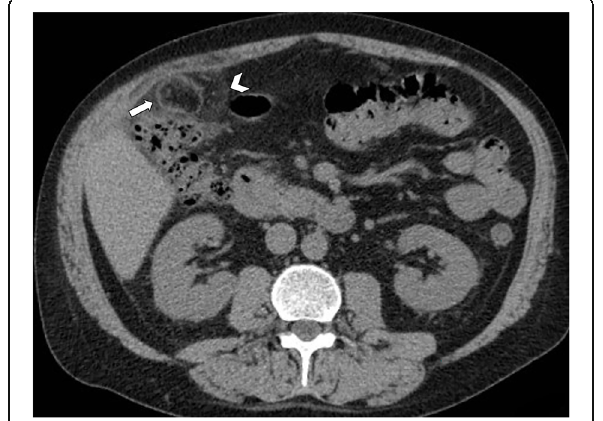
Fig. 4 Acute epiploic appendagitis in a 53-year-old man. Axial non- contrast CT image demonstrates a fat-density lesion (arrow) that abuts the hepatic flexure of the transverse colon. Mild fat stranding is surrounding the lesion (arrowhead)